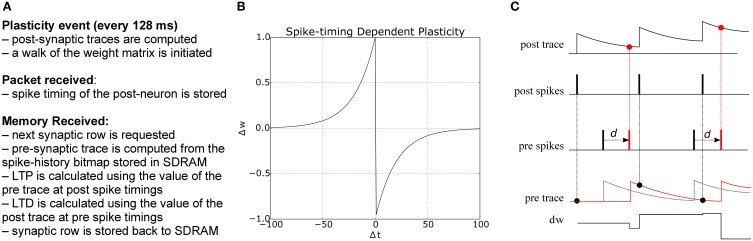
(A) Algorithm for STDP learning implementation on the plastic core (B) STDP function (C) Implementation of pair-based STDP with local traces and delays, as suggested by Morrison et al. (2008): potentiation occurs at post-synaptic spike times and corresponds to the value of the pre-synaptic trace; conversely, depression happens at pre-synaptic spike times and corresponds to the value of the post-synaptic trace. d represents the delay, reintroduced at the post-synaptic end; black and red lines represent the traces and spike timings when the delay is reintroduced (red) as opposed to using the presynaptic spike time as reference (black).